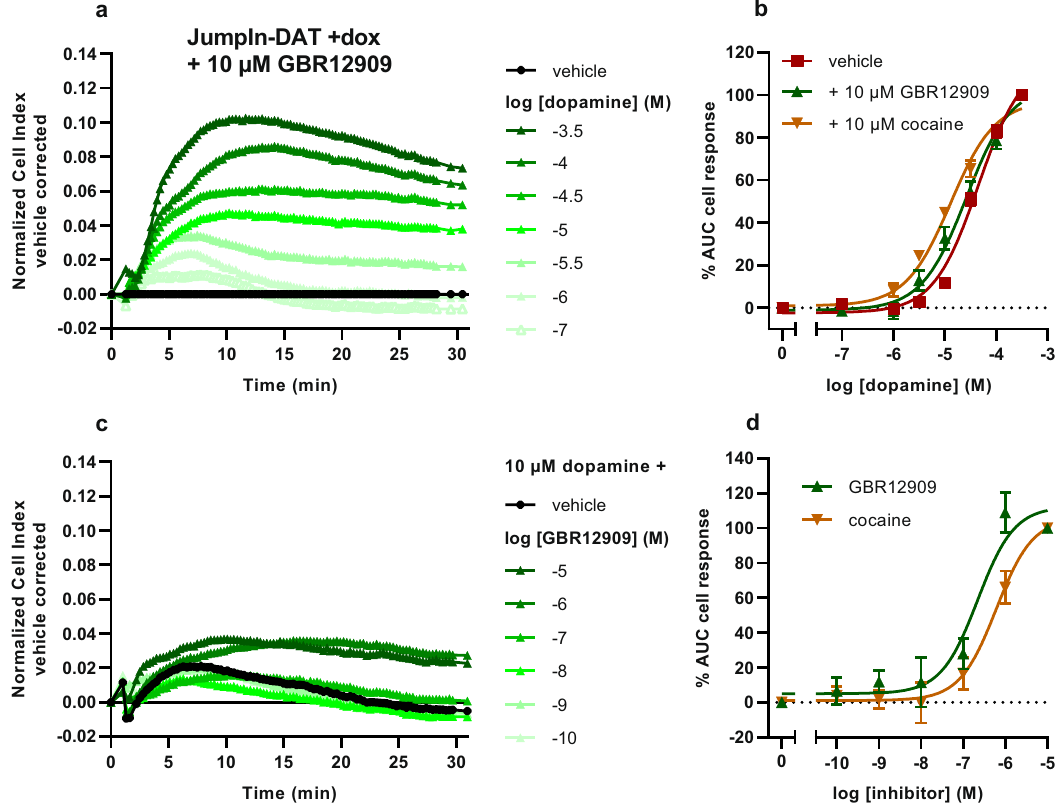
Figure 5. Functional characterization of GBR12909 and cocaine on DAT in JumpIn-DAT cells in the presence of 1 µg/ml dox (+dox) in a TRACT assay. Cells were pretreated with vehicle or 10 µM ( a,b ) or increasing concentrations ( c,d ) of either GBR12909 or cocaine. ( a ) Representative vehicle-corrected xCELLigence traces after stimulation with increasing concentrations of dopamine or ( c ) 3.16 µM dopamine. ( b ) Concentration- effect curves of dopamine in dox-treated JumpIn-DAT cells pretreated with vehicle or 10 µM GBR12909 or cocaine are shown as the net AUC of the first 30 min after stimulation normalized to the cell response of 316 µM dopamine. ( d ) Concentration-effect curve of GBR12909 and cocaine after addition of 10 µM dopamine normalized to 10 µM inhibitor. Data are shown as mean ± SEM of four to nine separate experiments each performed in